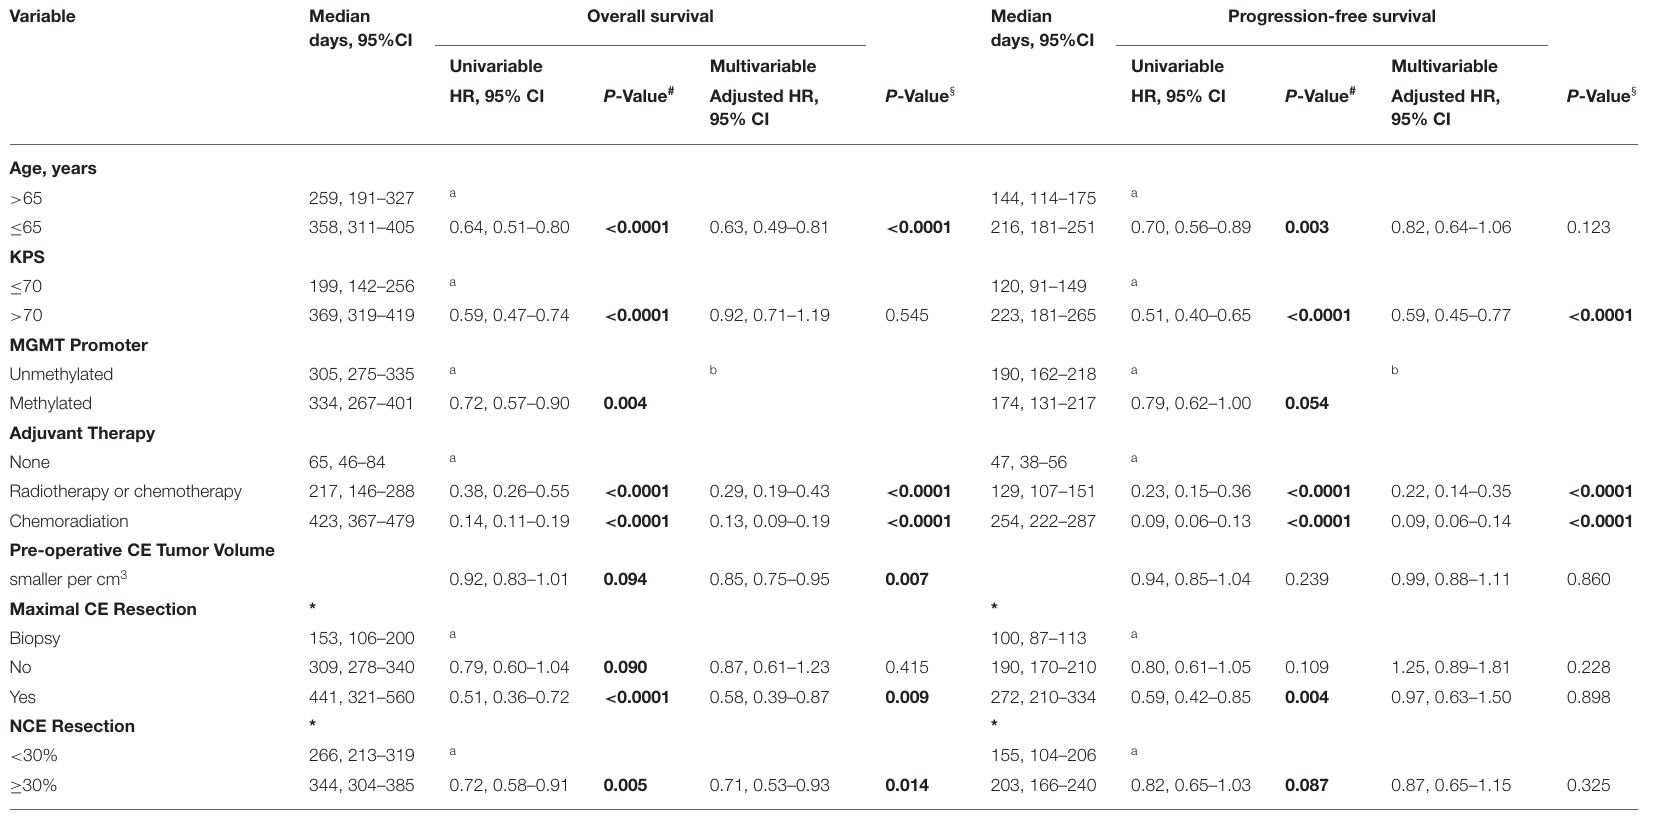
TABLE 2 | Cox proportional hazards models for overall survival and progression-free